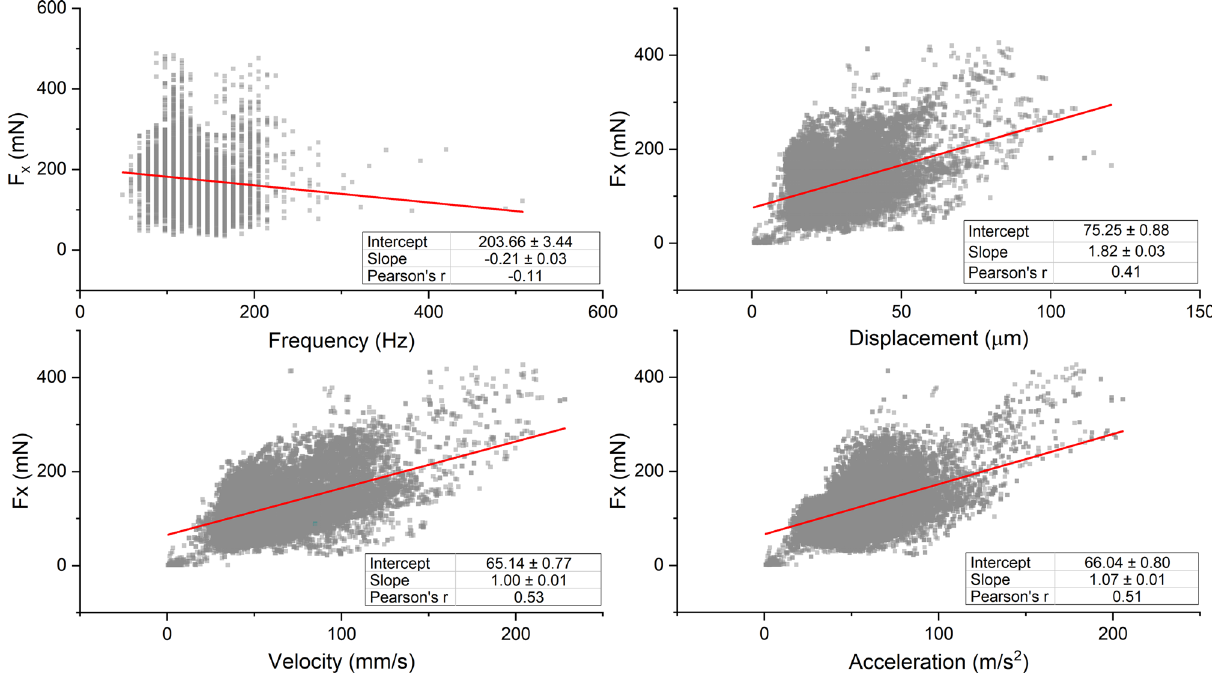
Figure 6. Scatter plots of thorax vibration frequency and peak displacement, velocity, and acceleration against peak force in the x-direction for all measurement intervals. The linear regression is shown in red. All regressions are significant at p < 0.001.